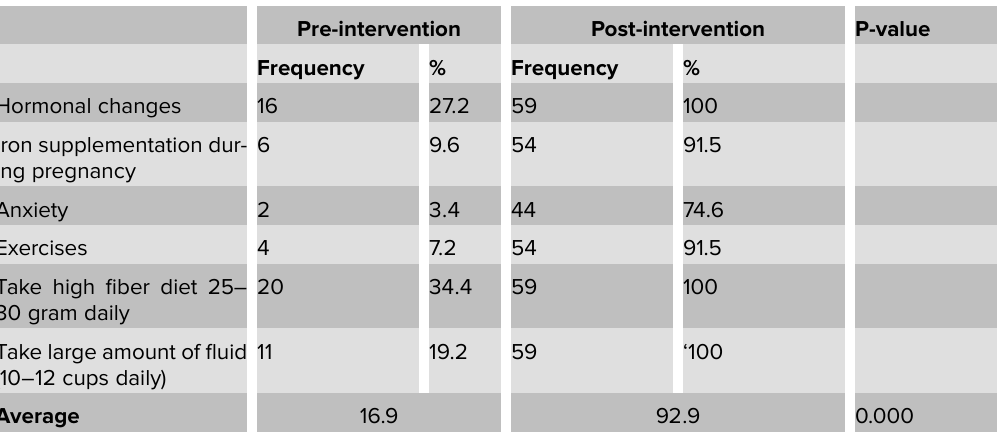
Table 3: Knowledge of the study population about causes and management of constipation during pregnancy pre- and post-intervention, n = 59.